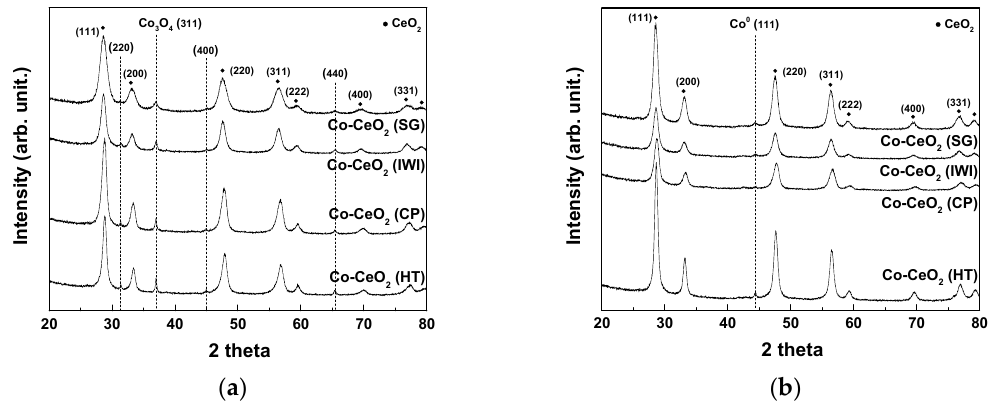
Figure 1. X-ray diffraction (XRD) patterns of Co–CeO 2 catalysts prepared by different synthetic Figure 1. X-ray di ff raction (XRD) patterns of Co–CeO 2 catalysts prepared by di ff erent synthetic methods: ( a ) Fresh, ( b ) Used. methods: ( a ) Fresh, ( b ) Used.